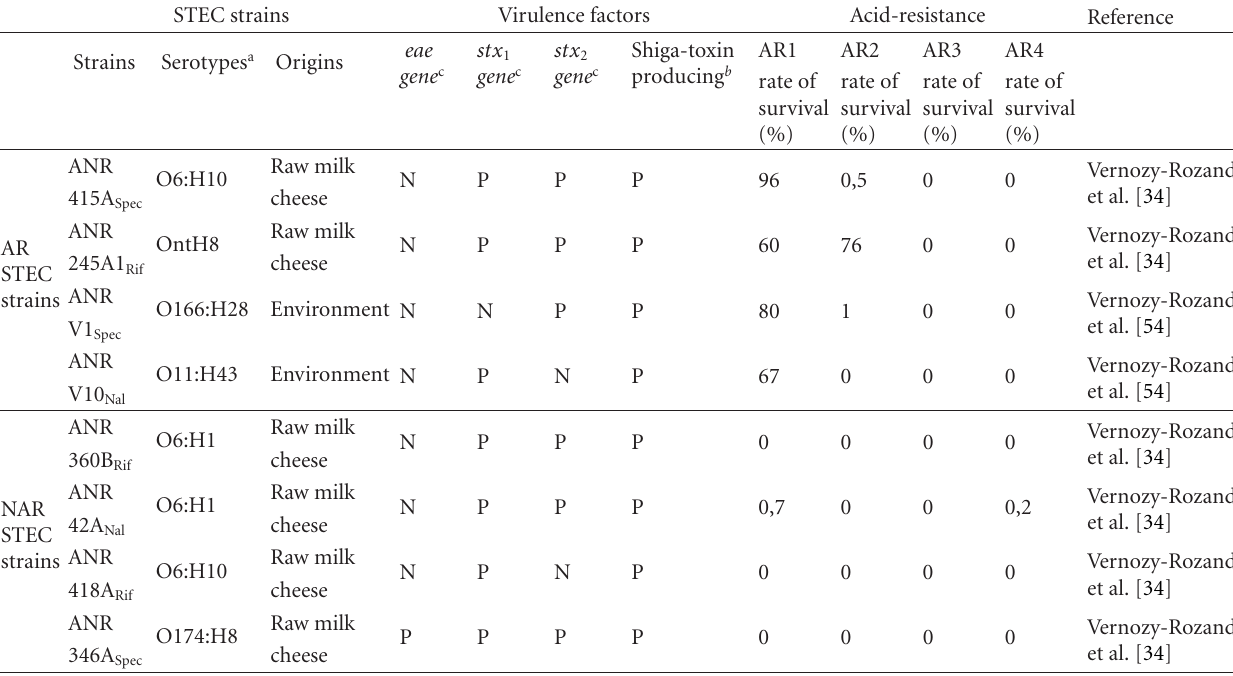
a Ont: O type not corresponding to any serogroup between O1 and O 174. b P production. c P,